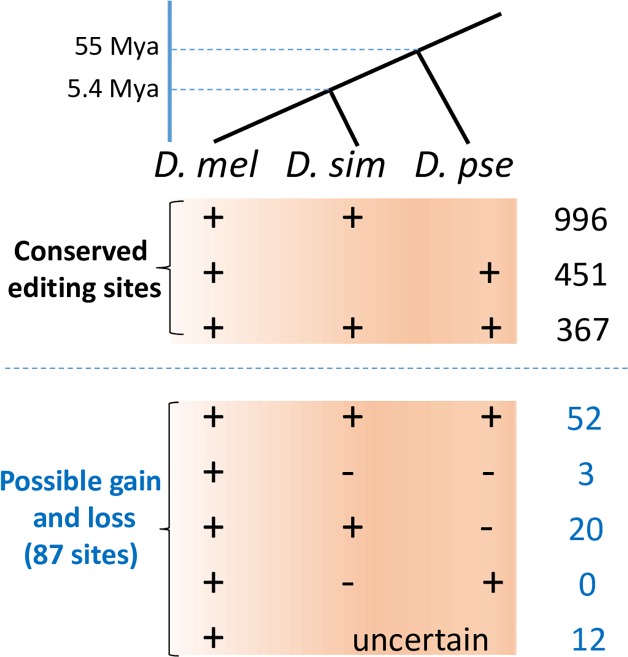
Conservation patterns of editing sites in brains of D. melanogaster and two other species.“+”, the high-confidence editing sites were reliably detected in a species (Top). Bottom: possible gain and loss patterns of 87 sites that have a minimal editing level of 0.05 in D. melanogaster and have at least 200 raw reads in both D. simulans and D. pseudoobscura. “-”, the orthologous site is not edited with high probability [joint P(D0) < 0.0002].